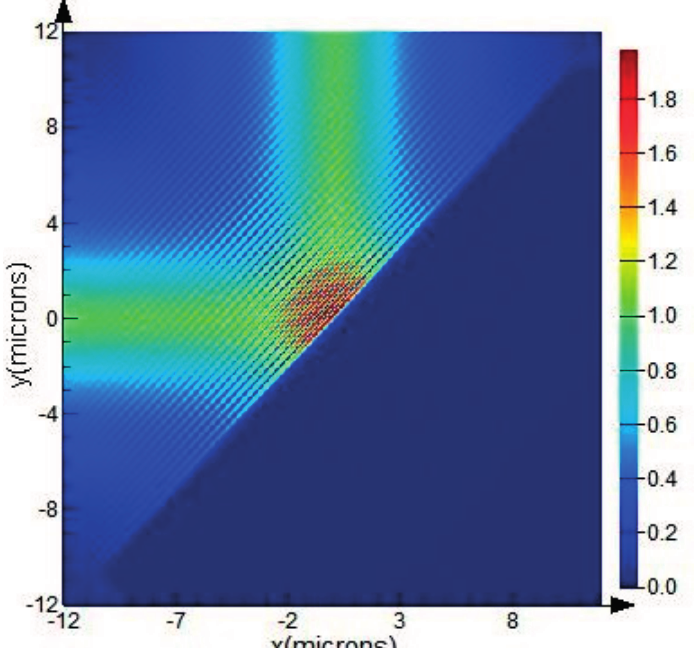
Figure 7. The electric intensity map in a plane 4 μ m above the SiO 2 layer for a 90° air-trench bend at a wavelength of 1550 nm. The SOI rib waveguide with a large cross section possesses a total rib height of 10 μ m, an outside rib height of 5 μ m, and a rib width of 2.5 μ m. The guiding mode is the fundamental EH mode. The width and length of the air trench is 10 μ m and 30 μ m respectively, and the Goos-Hanchen shift compensation D = 0. Bend efficiency calculated through the 2D-FDTD simulation with mesh grid of 5 nm is 0.999746.